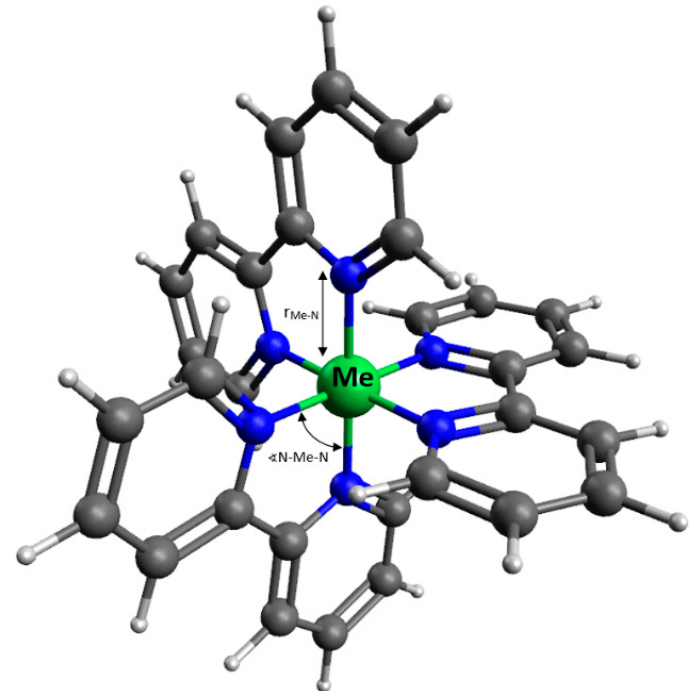
Figure 2. Geometry of optimized Me-bpy coordination complex on the example of bpyPDMS-NiCl 2 . The total spin in the ground state and the average geometry parameters for each complex used in the calculations are shown in Table 1. Ground-state spins of the complexes were determined based on literature data [33,34]. The values of standard deviations were used to determine the irregularities of the molecule’s geometry Table 2. The detailed geometry-optimized structure of Me-bpy complexes is listed in Table S1 (Supporting Information). Table 1. The total spins of the complexes in the ground state [33,34].